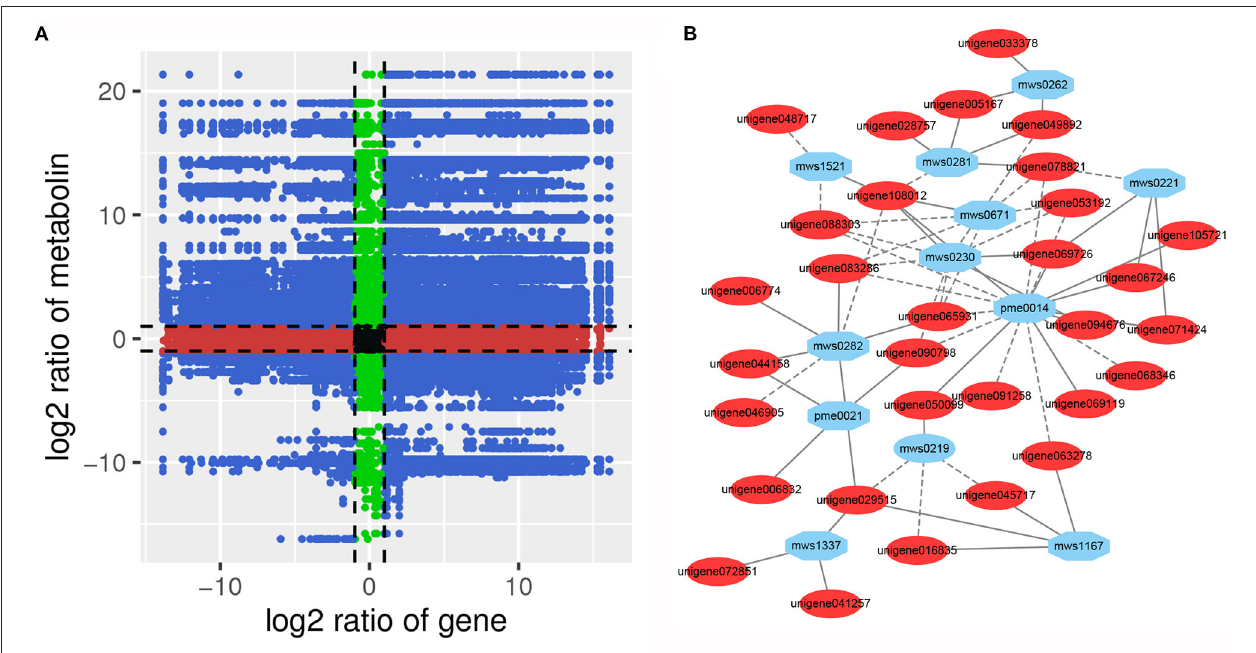
FIGURE 9 | (A) Nine quadrant diagram showing the correlation of differentially expressed genes and differentially accumulated metabolites between SG and SZ libraries. (B) Connection network between differentially expressed genes (blue ovals) and differentially accumulated metabolites (red